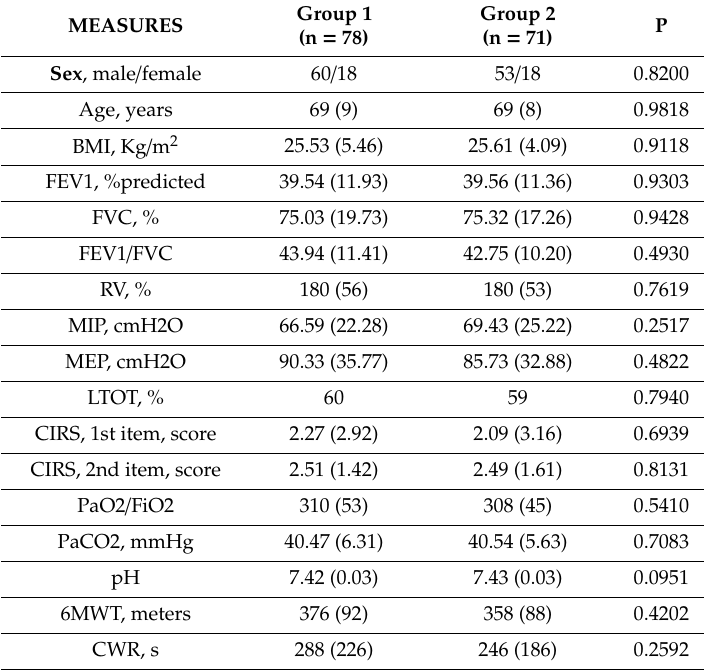
Table 1. Anthropometric and clinical characteristics of included